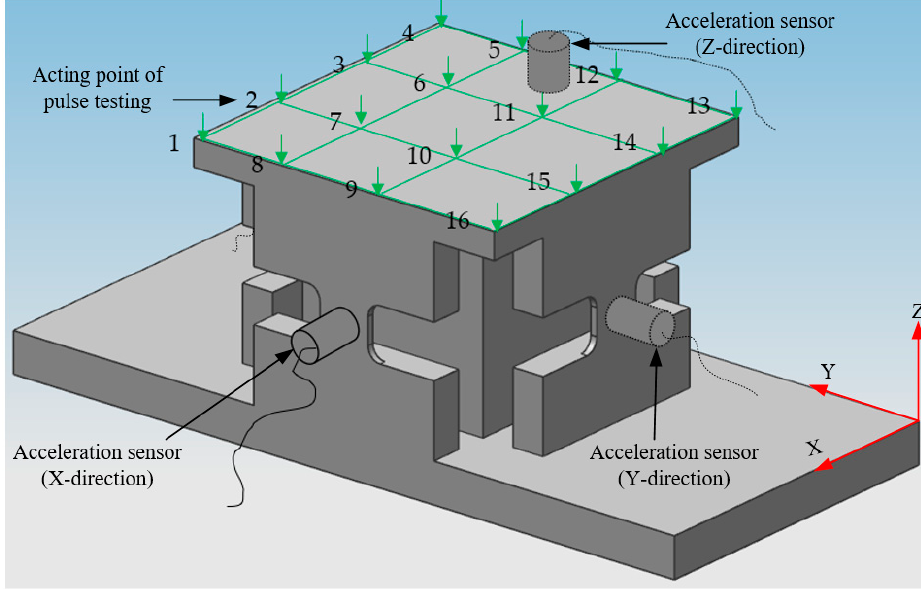
Figure 6. Schematic diagram of the pulse test.